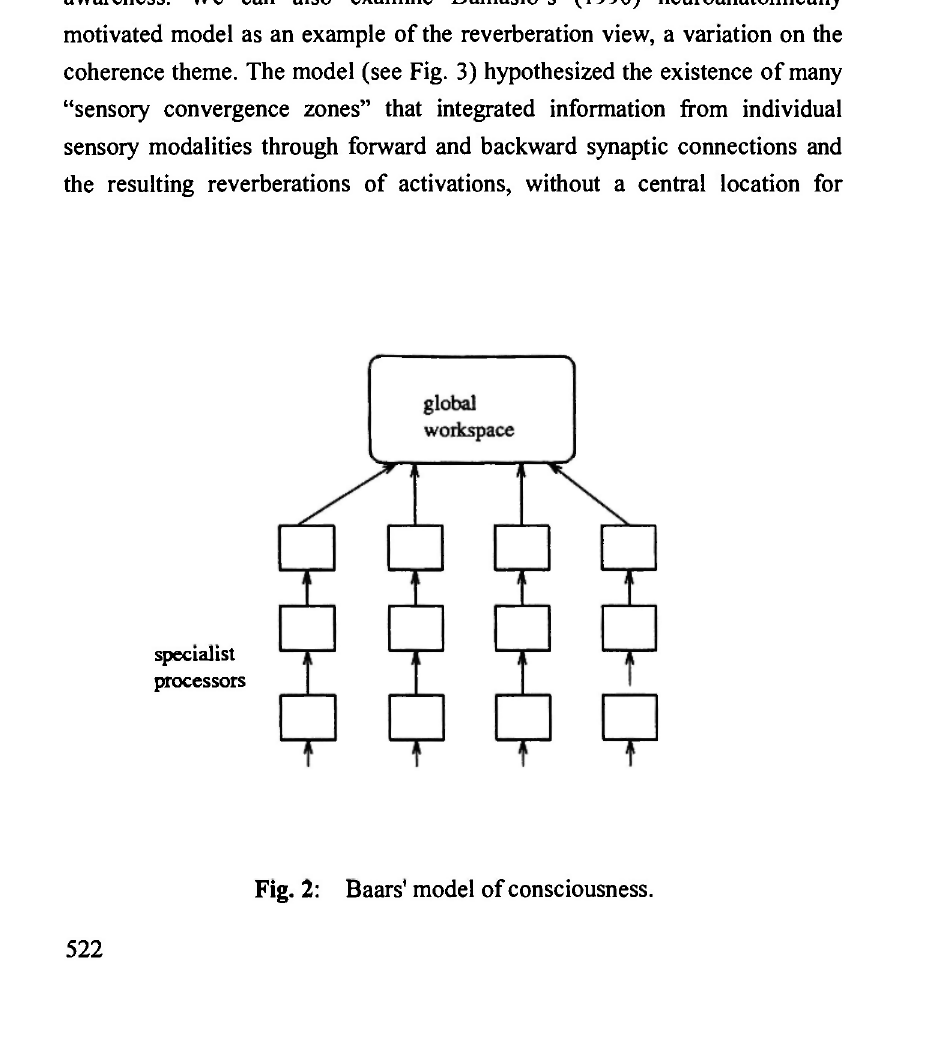
Fig. 2: Baars' model of